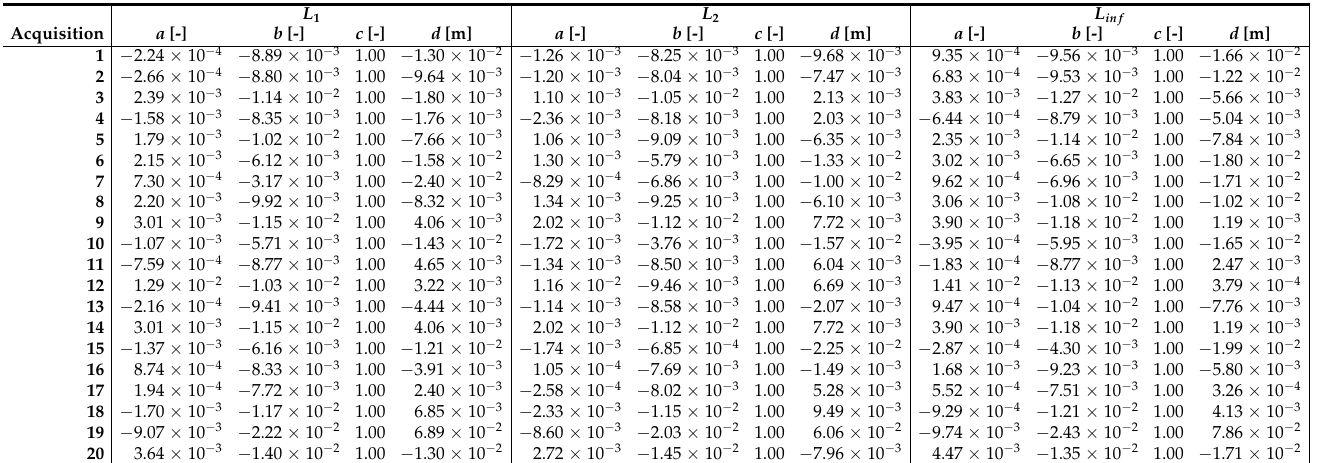
Table 3. Values of coefficients a, b, c and d for the 20 meshes of the roof feature identified by Figure 3. L 1 L 2